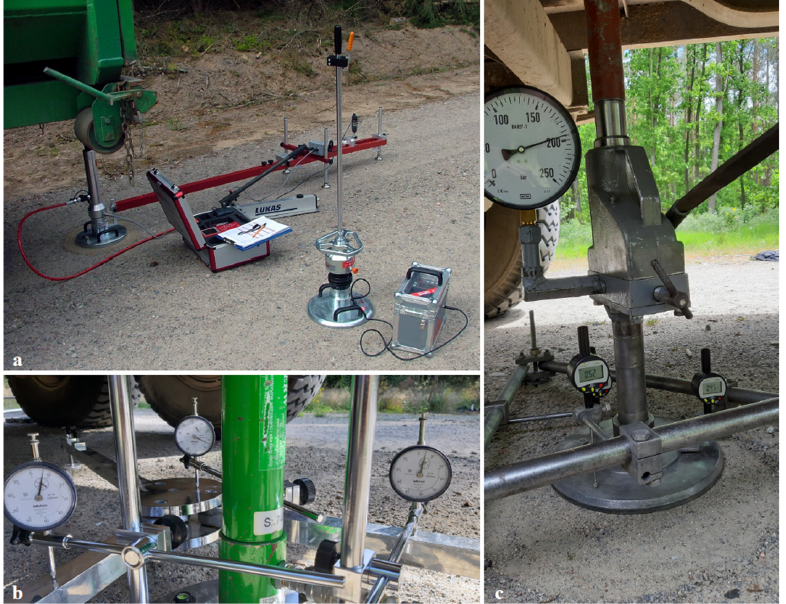
Figure 2. Equipment used for measuring the bearing capacity of forest roads: ( a ) light falling weight deflectometer Zorn ZFG 3000 GPS (foreground), and static load plate HMP PDG Pro (background); ( b ) static load plate VSS-3P-000 with 3 analogue displacement sensors; ( c ) static load plate VSS-3P with 3 electronic displacement sensors (Photos: S.M.